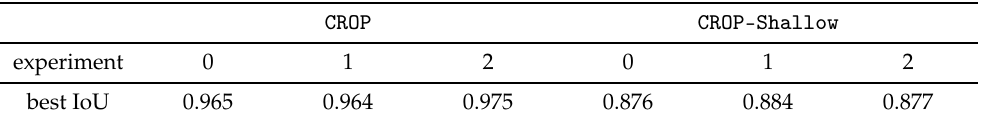
Table 2. The best IoUs for the validation datasets with CROP and CROP-Shallow , with epoch not more than 2500, using the training dataset (80%: 137) and the validation dataset (20%: 35) of Data_Fruit . Three experiments, numbered from 0 to 2, were performed for each.